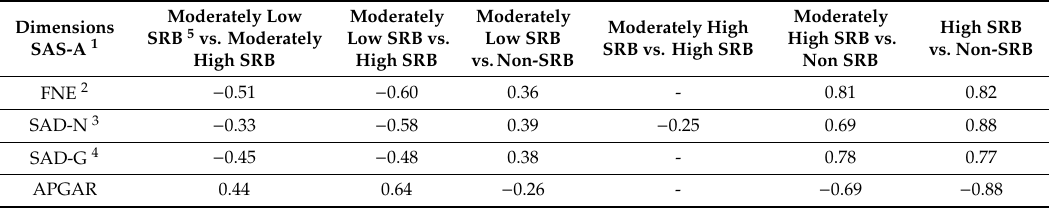
Table 4. Cohen’s d value for post hoc contrasts between cluster groups for SAS-A dimensions. Dimensions SAS-A